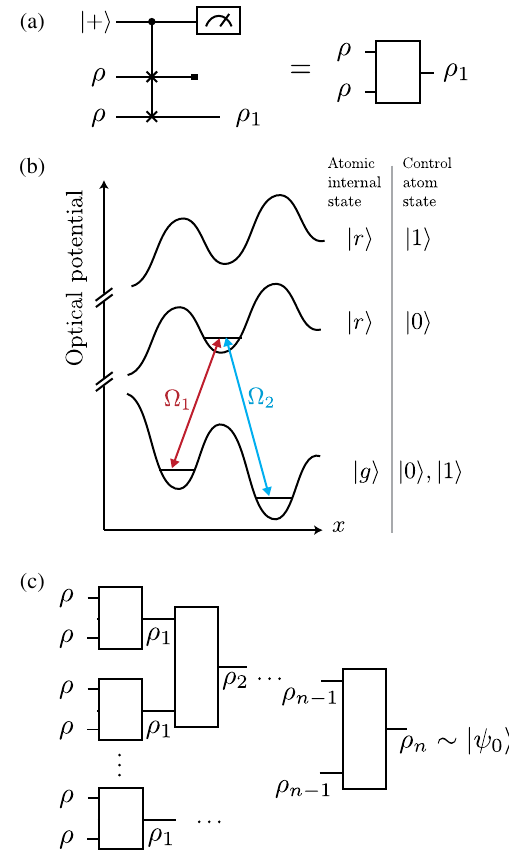
FIG. 3. (a) Quantum circuit representation of ancilla qubit virtual cooling protocol. Following the controlled SWAP of two copies of a quantum state, the control ancilla qubit is measured. If the qubit is measured to be j 0 i , then one of the system copies is discarded and the remaining system copy is in the state ρ 1 . (b) The controlled SWAP operation can be implemented for ultracold atoms on an optical lattice by the combination of photon-assisted hopping and the Rydberg blockade mechanism; excitation of the control atom in a Rydberg state conditionally prevents photon-assisted hopping. (c) Quantum circuit represen- tation of ground-state distillation protocol. The protocol in (a) can be parallelized and nested, as shown in the diagram. If ρ is a thermal state, then the ground state will be